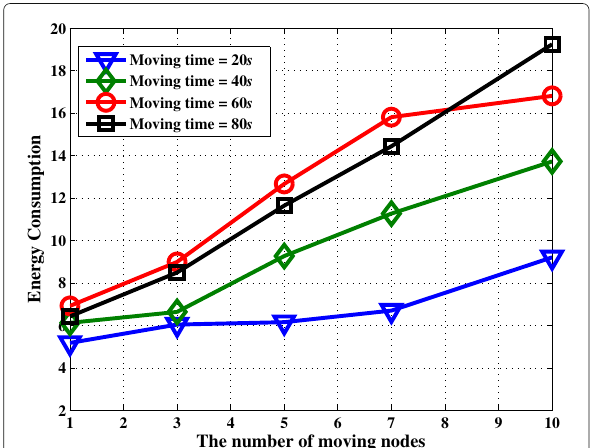
Fig. 3 The relation between energy consumption and the number of moving nodes